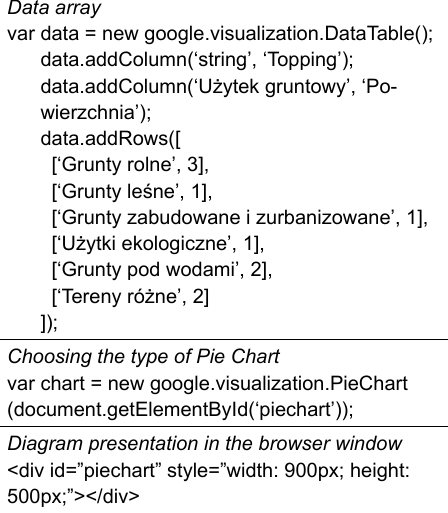
Table 7. The snippet of HTML and JavaScript presenting the pie diagram (Google Charts) in a browser window Data